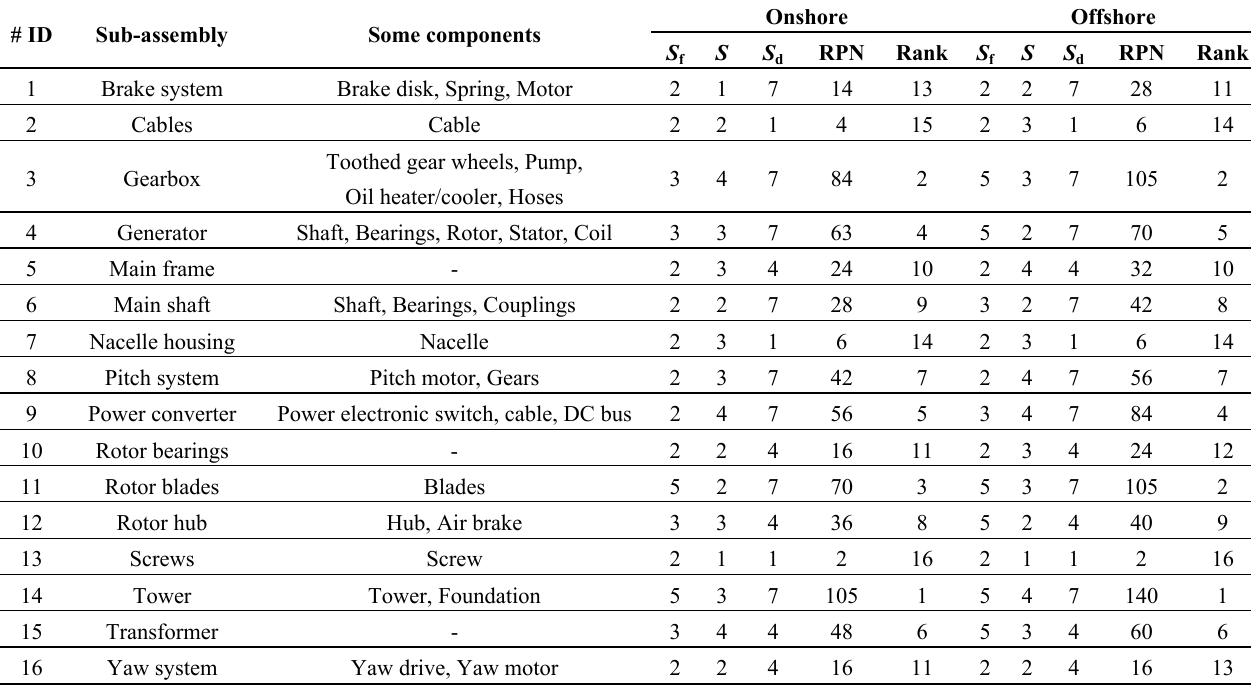
Table 7. The RPN values for the onshore/offshore wind turbine sub-assemblies (sub-assemblies are listed in alphabetical order).